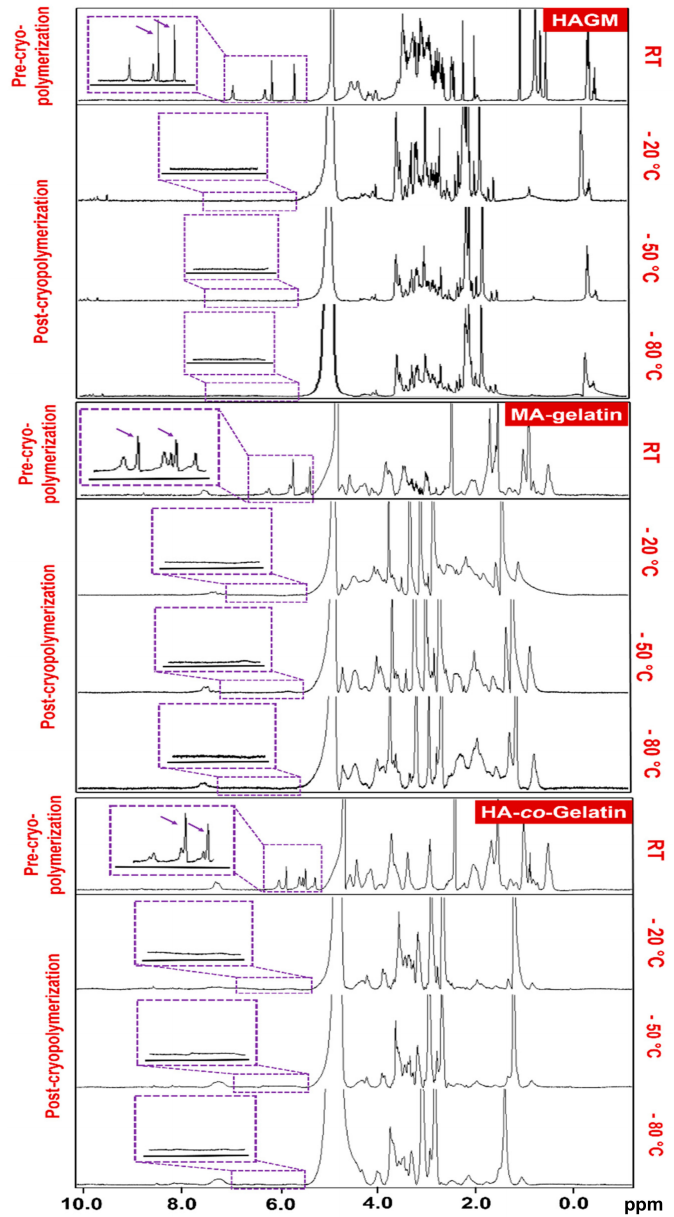
Figure 1. Chemical characterization of polymers by 1 H NMR. 1 H NMR spectra of